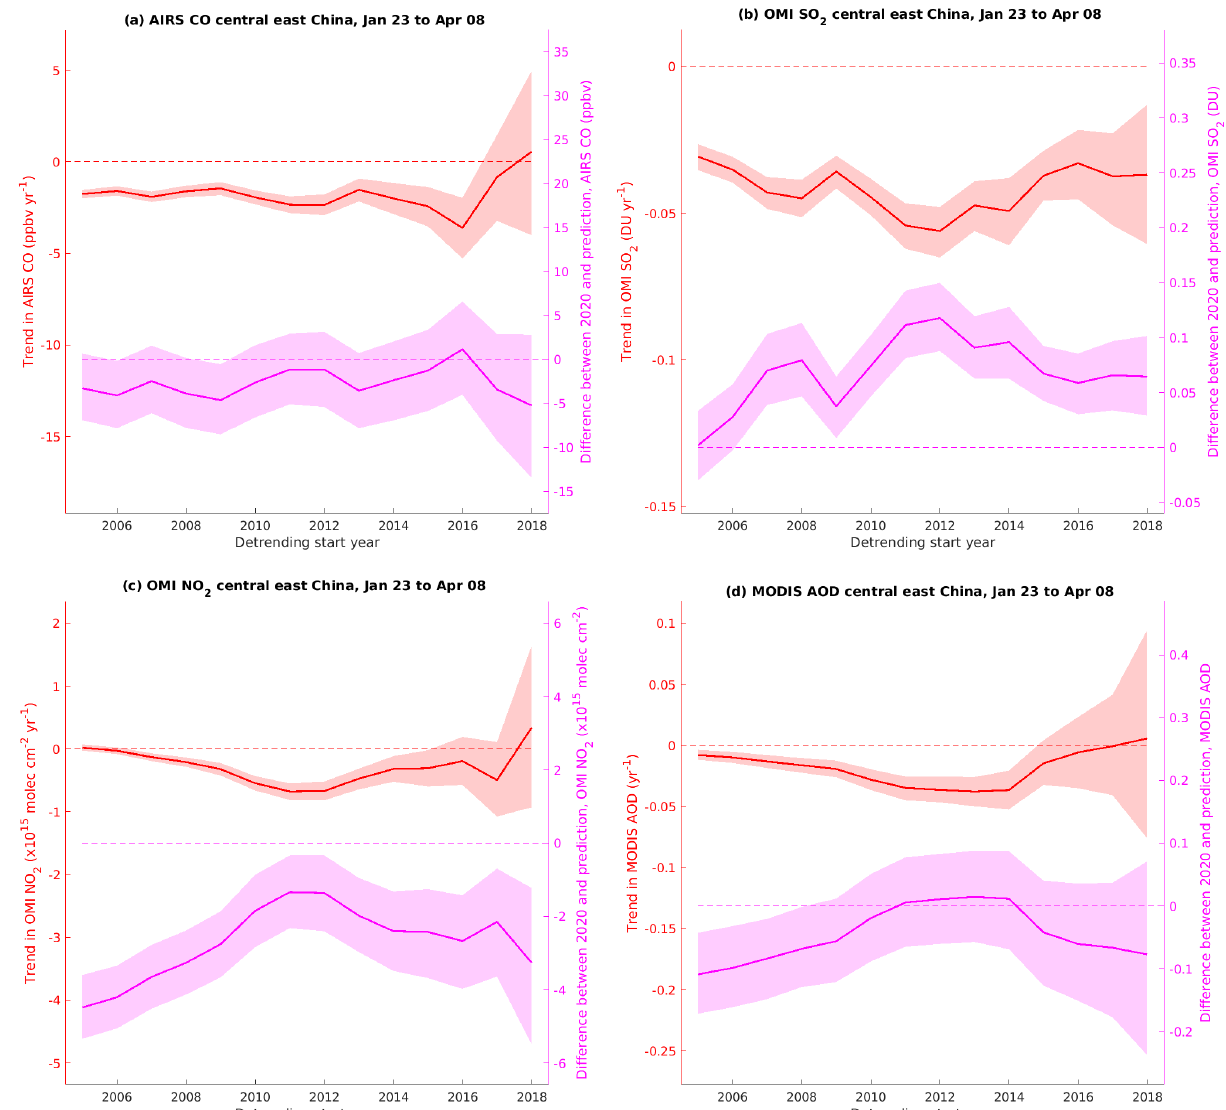
Figure 6. Dependence of trends (red) and difference between 2020 observations and predicted value (magenta) on detrending start year over central east China for (a) AIRS CO, (b) OMI PBL SO 2 , (c) OMI tropospheric NO 2 , and (d) MODIS AOD. The solid line shows the mean of the estimate for each year and the shading shows the 95% confidence